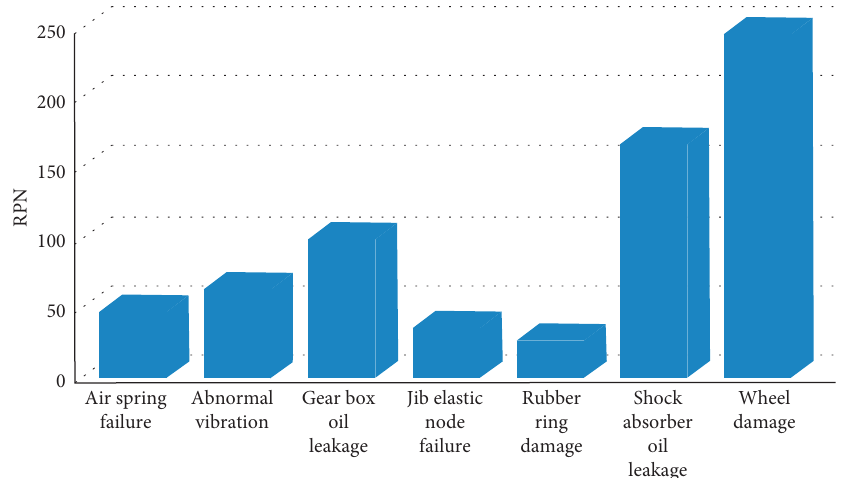
Figure 4: RPN of failure modes.